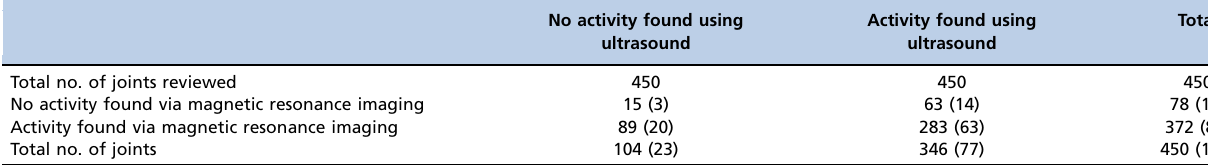
Table 3 - Agreement between the two imaging modalities used.